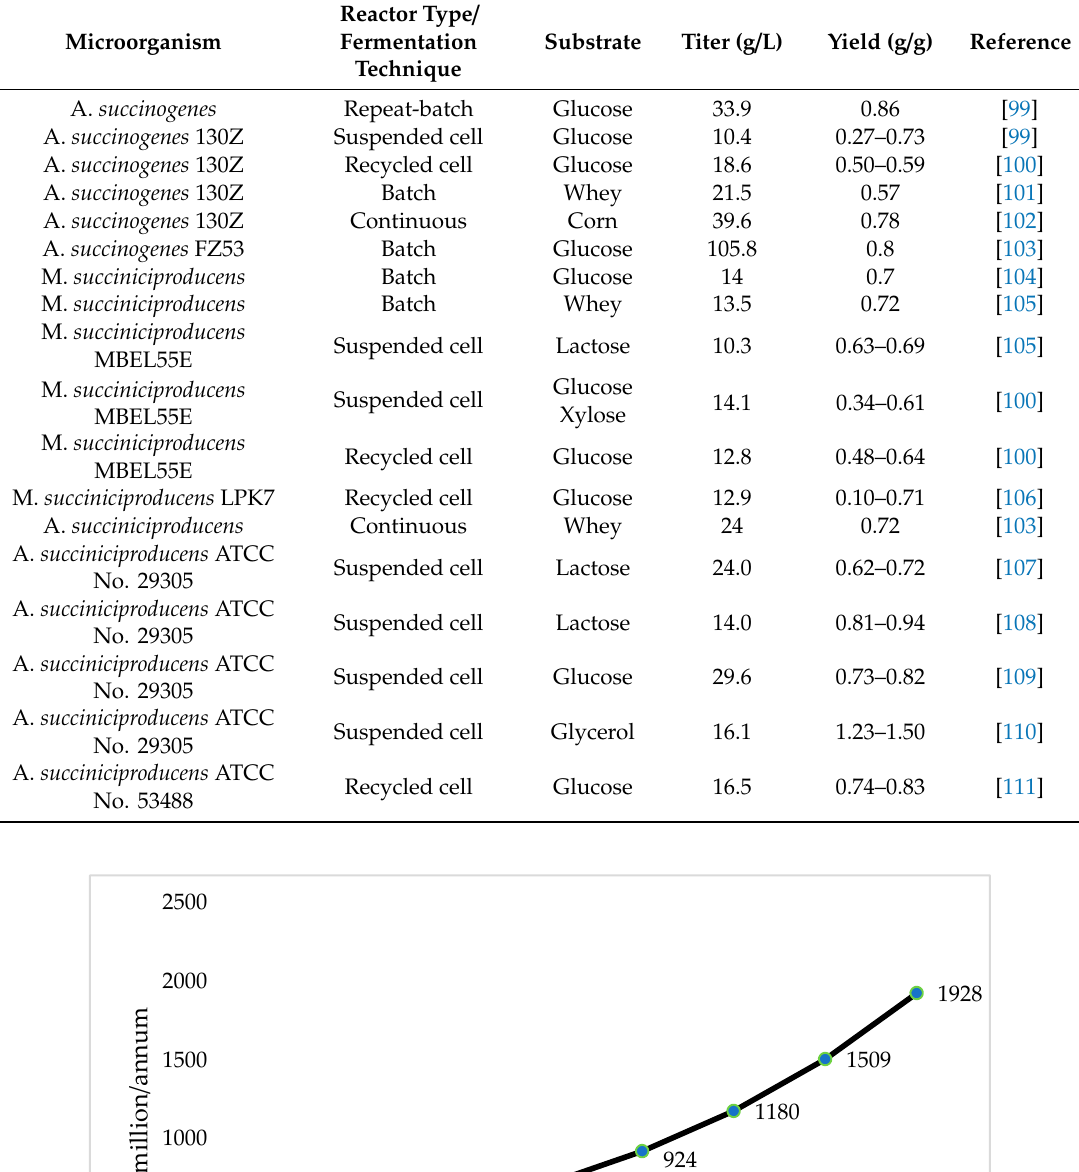
Table 6. Summary of performances of succinic acid fermentation studies by various microorganisms.